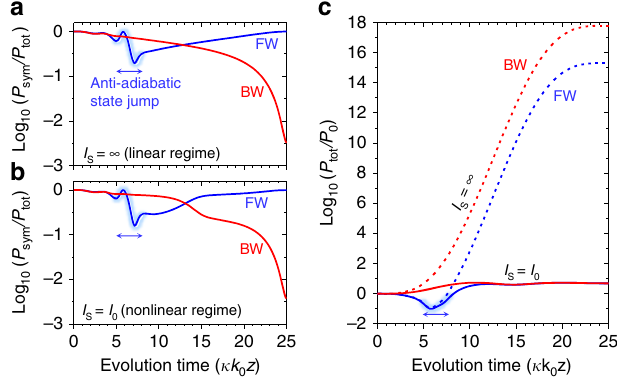
Figure 4 | Strictly nonreciprocal transmission with gain saturation. ( a , b ) Even-mode power ratio P sym / P tot profiles while encircling an EP for the forward (FW, blue curve) and backward (BW, red curve) passages with no gain saturation ( I S ¼ N ) and strong gain saturation ( I S ¼ I 0 ), respectively. Here, I S denotes a gain saturation intensity constant. ( c ) Total power history while encircling an EP for the forward (blue curves) and backward (red curves) passages with no gain saturation ( I S ¼ N , dotted curves) and strong gain saturation ( I S ¼ I 0 , solid curves). Regions of anti-adiabatic state jumps are indicated by light-blue highlighting and a double-sided